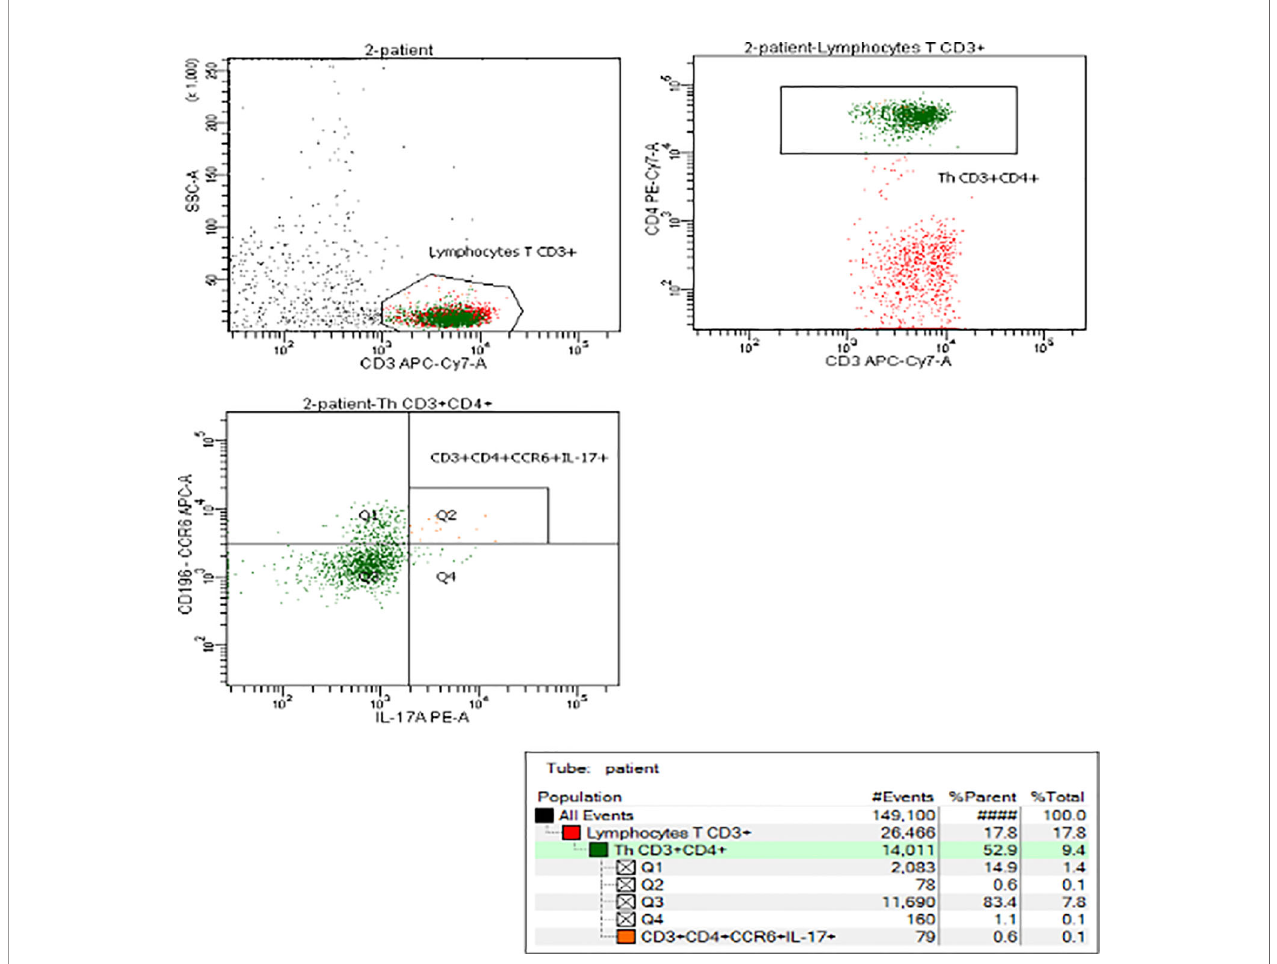
FIGURE 1 | Representative fl ow cytometry analysis of Th17 cells in obese